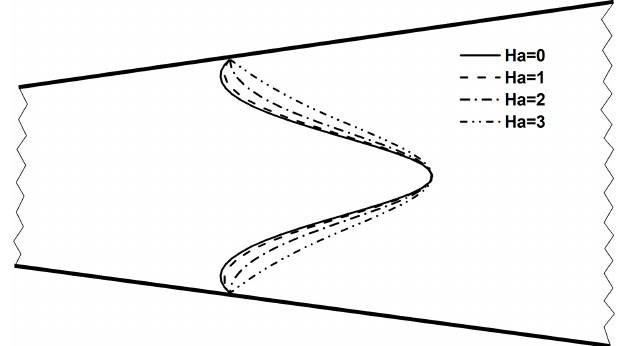
Figure 4. Hartmann number effect on the dimensionless velocity profile for α Re = 14 .